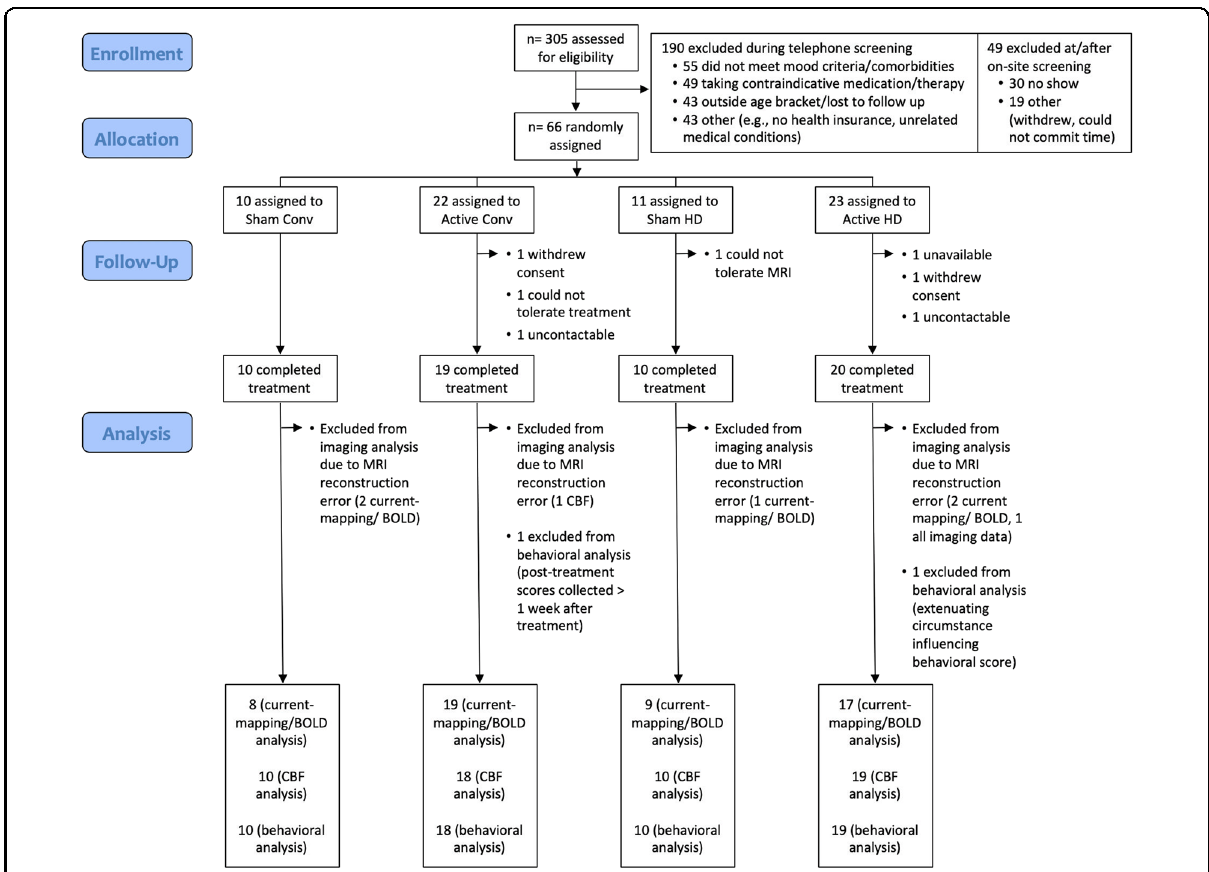
Fig. 1 CONSORT diagram. Three hundred and fi ve participants were assessed for eligibility, of which 239 participants were excluded at screening (for a full list of exclusionary criteria, see supplementary material S1). Post screening, 66 participants were enrolled and randomly assigned to treatment groups (Sham Conventional (Conv), Active Conv, Sham high-de fi nition (HD), and Active HD tDCS). Data was analyzed for the participants that completed treatment ( N = 59). Out of these, imaging data from six current-mapping/BOLD datasets and two pCASL CBF datasets was excluded due to MRI-reconstruction errors. Additionally, behavioral data from two participants was excluded because of extenuating circumstances that delayed the collection of scores and the occurrence of a family-emergency,